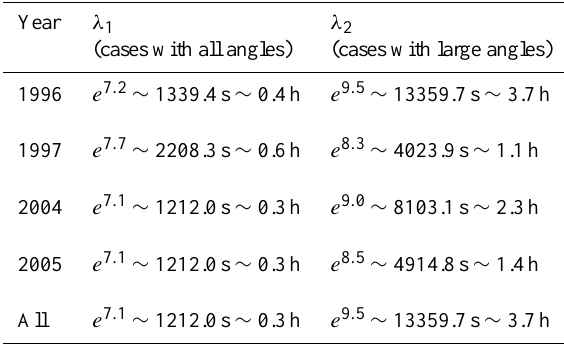
Table 1. The most intermittent